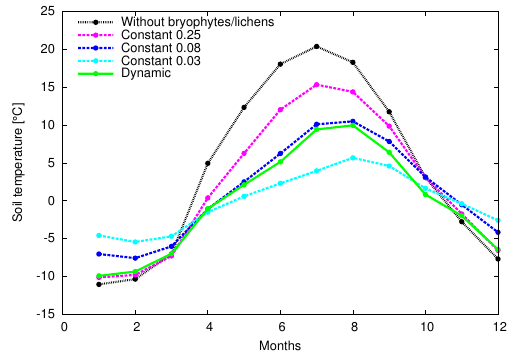
Figure 7. Temperature of the uppermost soil layer of a model grid cell at 55 ◦ 30 (cid:48) N, 98 ◦ 30 (cid:48) W, which is also used for the sensitivity analysis (Sect. A in the Appendix). The dots stand for monthly aver- age values for the period 1996 to 2010. Without denotes a transient simulation from 1901 to 2010 without a bryophyte and lichen layer. “Constant 0.25” denotes an equivalent simulation, but including an organic layer with constant coverage and thermal properties. The thermal conductivity of this layer is set to 0.25 [WK − 1 m − 1 ] as in Ekici et al. (2014). “Constant 0.08” corresponds to an organic layer calibrated to reproduce topsoil temperature under the bryophyte and lichen layer in summer. “Constant 0.03” corresponds to an organic layer calibrated to reproduce average annual topsoil temperature un- der the bryophyte and lichen layer. Dynamic stands for a bryophyte and lichen layer with dynamic coverage and thermal